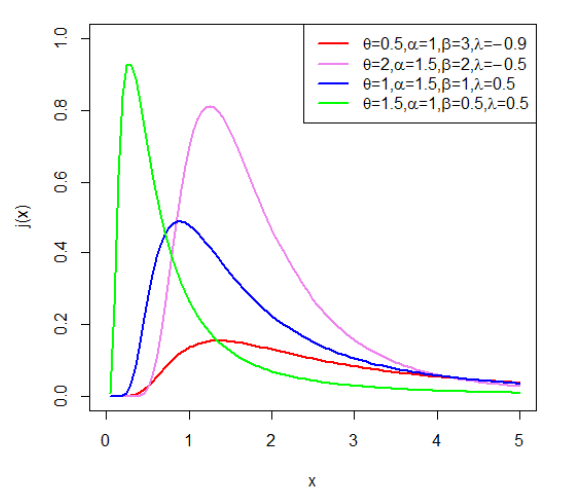
Figure 3 – Pdf of ET F distribution for various choices of θ , α , β and λ